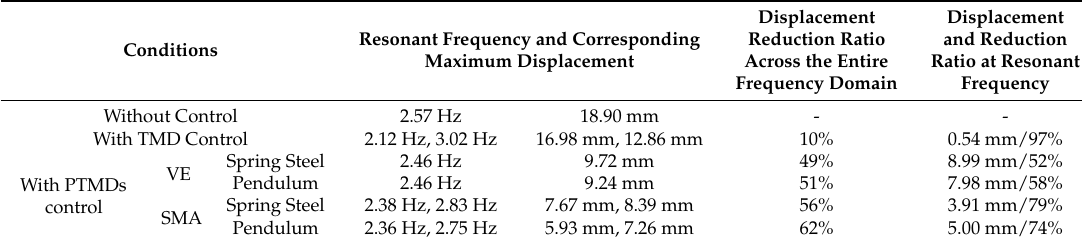
Table 3. The results of forced vibration.